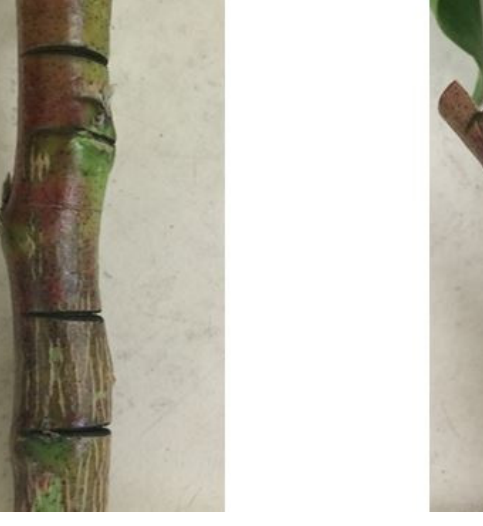
Figure 21. Figure details the regression analysis for the laser power tests that were performed on freshly harvested field ‐ grown cotton plants to determine cutting depth versus laser ‐ power. Results are from plants ranging in height from 250 mm to 725 mm. A zero depth corresponds to the depth where the laser just penetrated through the bark and the phloem tissue. The negative depth indicates insufficient power. To ascertain if a priori knowledge of either bark thickness or stem diameter would help to assess power requirements for optimal girdling cuts, a subset of the data was selected where the laser had just penetrated past the phloem and bark layer by no more than 0.5 mm. A regression analysis on this subset was performed comparing laser power to bark thickness as well as to stem diameter. In both cases, the correlations were exceedingly poor with coefficient of determinations less than r 2 = 0.05. Hence, the best guidance for the power requirements for laser girdling treatment